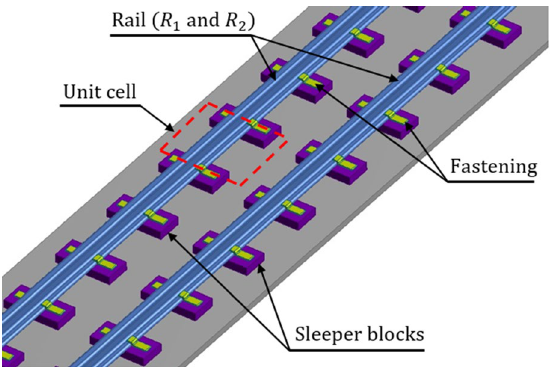
Figure 1. Layout of a ballastless railway track fixed on sleeper blocks using